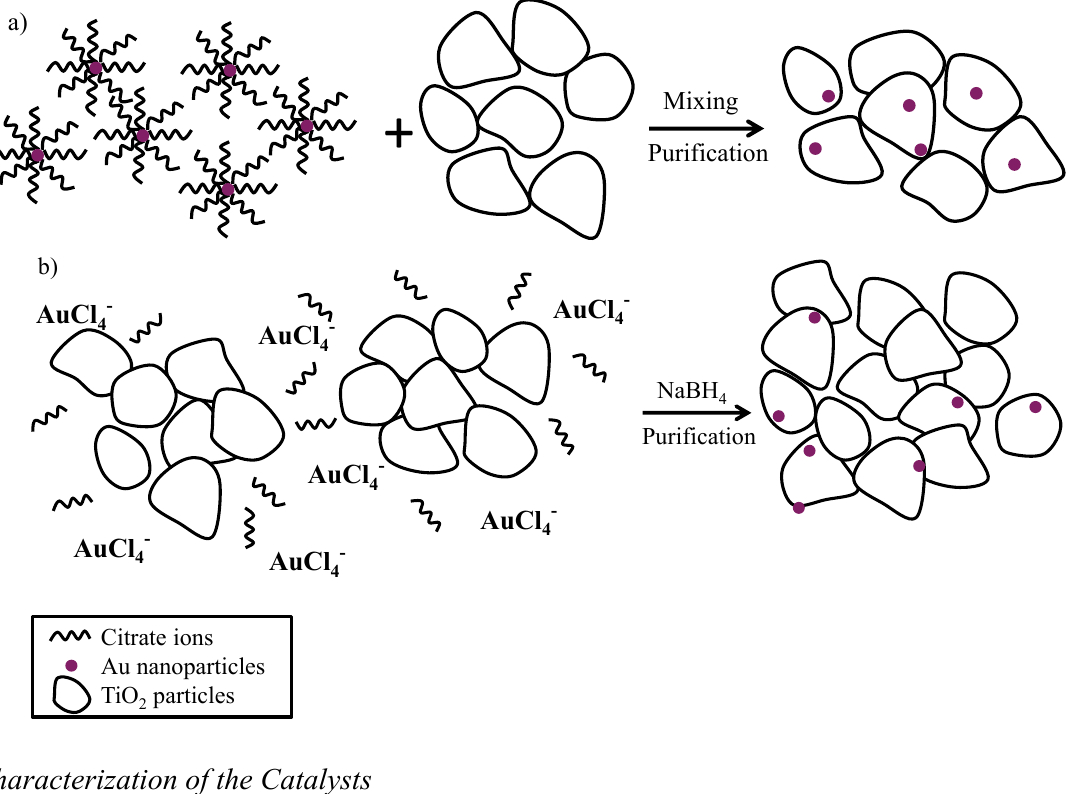
Figure 1. Synthesis of Au-TiO 2 samples by chemical reduction: ( a ) Chemically